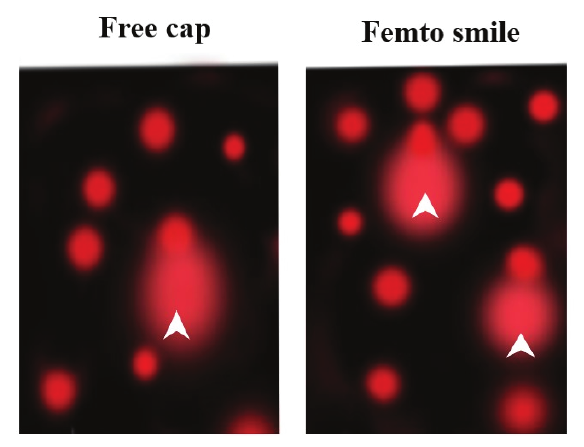
Figure 4. Representative Comet images of human cornea for free cap and Femto SMILE group showing a circular head corresponding to the undamaged DNA that remains in the cavity and a tail of damaged DNA (arrow head). Propidium iodide solution (2.5 µg/ml) gel Stain, Scale bars: 100